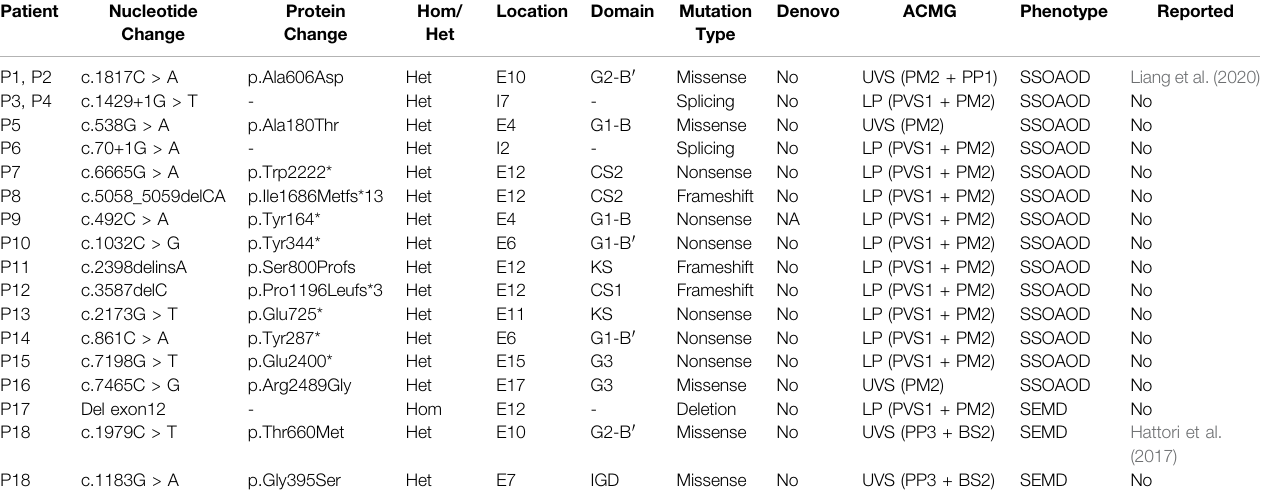
TABLE 1 | Mutations of ACAN gene identi fi ed in this study.